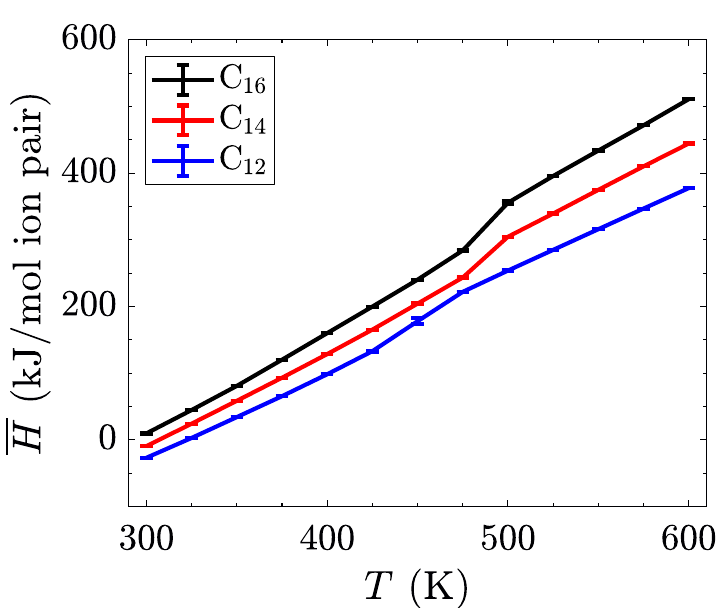
Figure 5. Intrinsic enthalpy as a function of temperature for three different alkyl chain lengths. The phase transitions are less pronounced in this system-wide property, but can be identified by the changes in slope of each